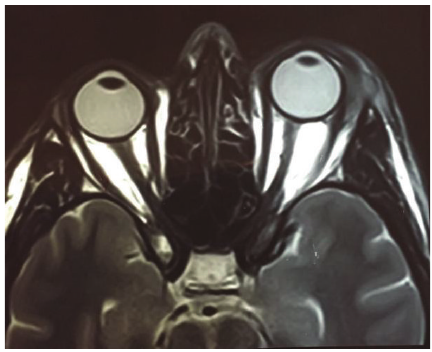
Figure 3: Axial T2-anterior projection of the left eye globe in relation to the contralateral.